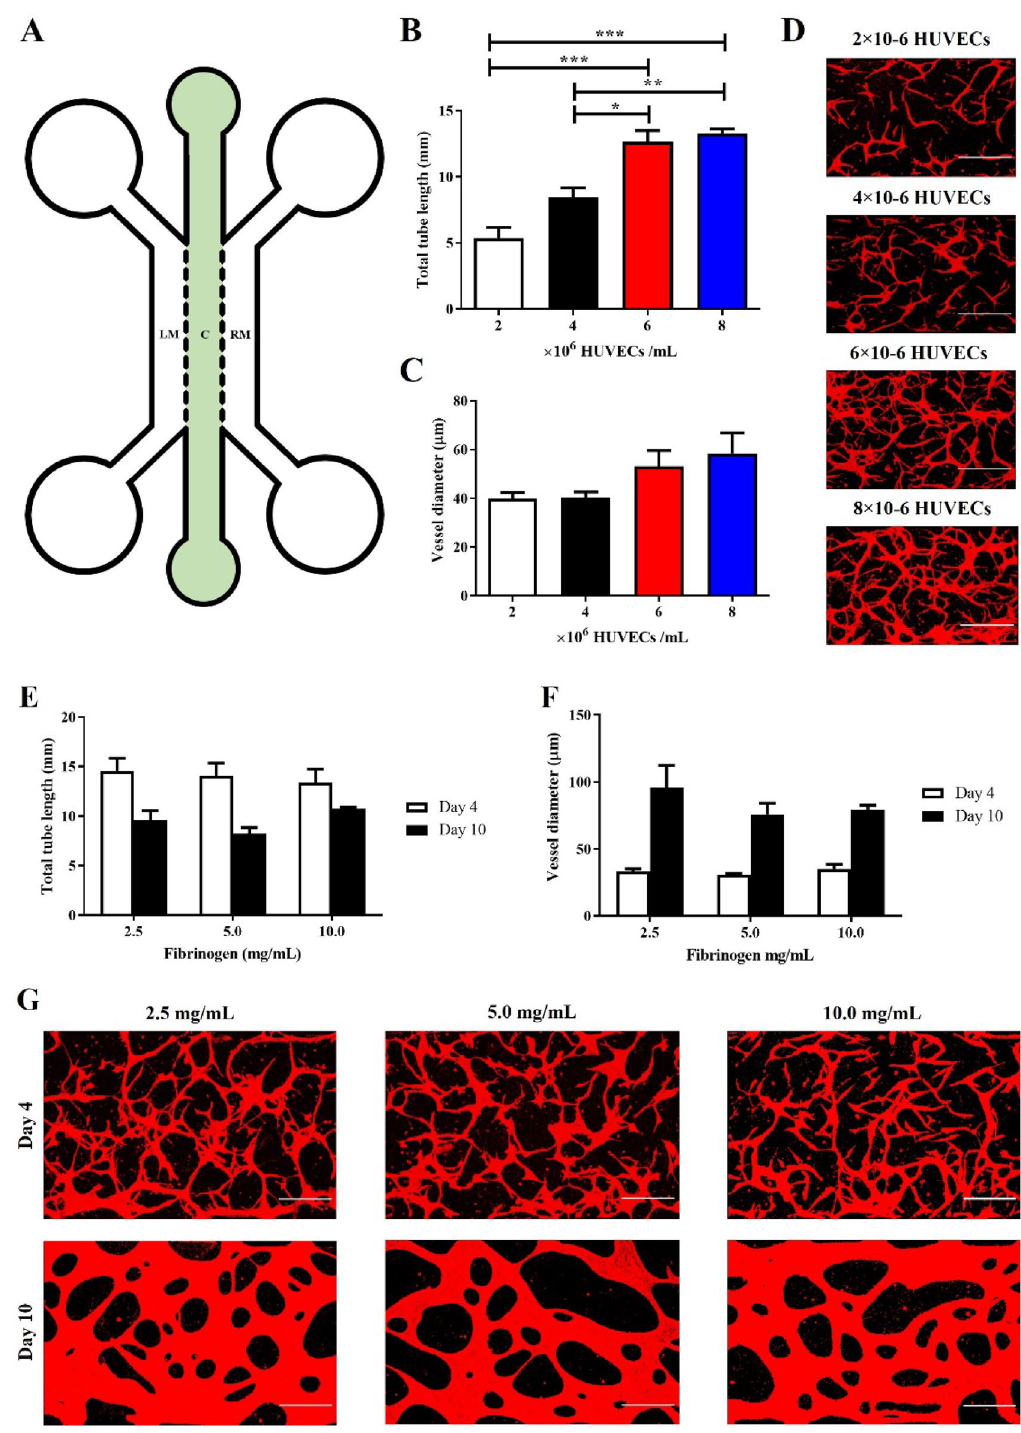
Figure 1. The impact of cell density and fibrinogen concentration on vasculogenesis. ( A ) Schematic of chip design. Central channel (noted c) is 1000 µm wide and separated from the lateral medium channels (LM and RM) by 300 µm long hexagonal posts, spaced by 75 µm gaps. ( B ) Increasing HUVEC density significantly increases total tube length (5.4 ± 0.8, 8.4 ± 0.7, 12.7 ± 0.9 and 13.3 ± 0.4 mm/field of view for 2, 4, 6, 8 × 10 6 HUVECs/mL respectively). ( C ) HUVEC density had no significant impact on vessel diameter (mean range 39.8–58.4 µm). ( D ) Representative images of different HUVEC densities, z-projection images were generated from confocal images. Red, F-actin. Scale bar: 300 µm. ( E ) Fibrinogen concentration had no significant impact on total tube length at day 4 (mean range 13.4–14.5 mm/field of view), or day 10 (mean range 8.2–10.7 mm/field of view). ( F ) Fibrinogen concentration also had no impact on vessel diameter following 4 days (mean range 30.6–35.0 µm), or 10 days of culture (mean range 75.8–95.8 µm). ( G ) Representative images of networks formed at different fibrinogen concentrations, z-projection images were generated from confocal images. Red, F-actin. Scale bar: 300 µm. N = 3; n.s., non significant; *, p < 0.05; **, p < 0.01; ***, p <